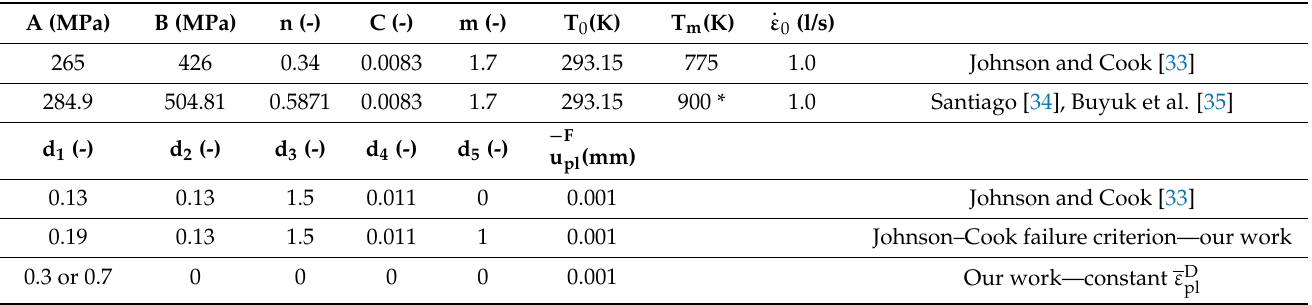
Table 1. Material parameters for the Johnson–Cook model and the failure